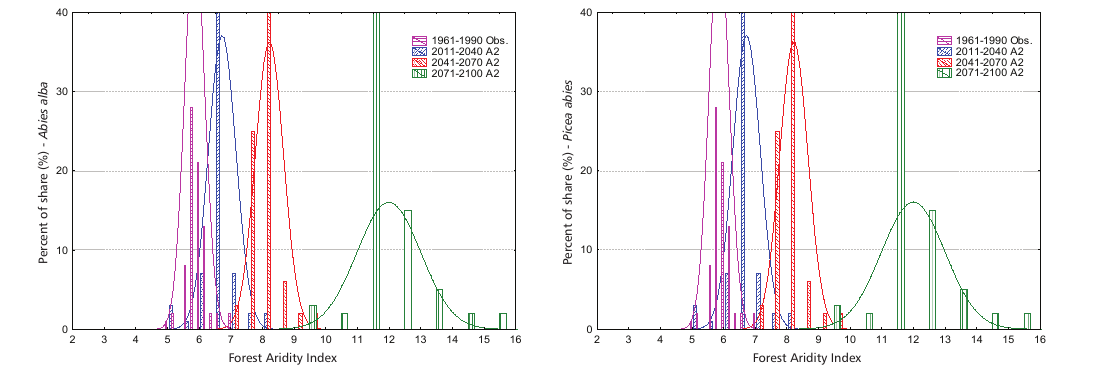
FIGURE 8. Distribution of Silver fir across FAI categories in four climate